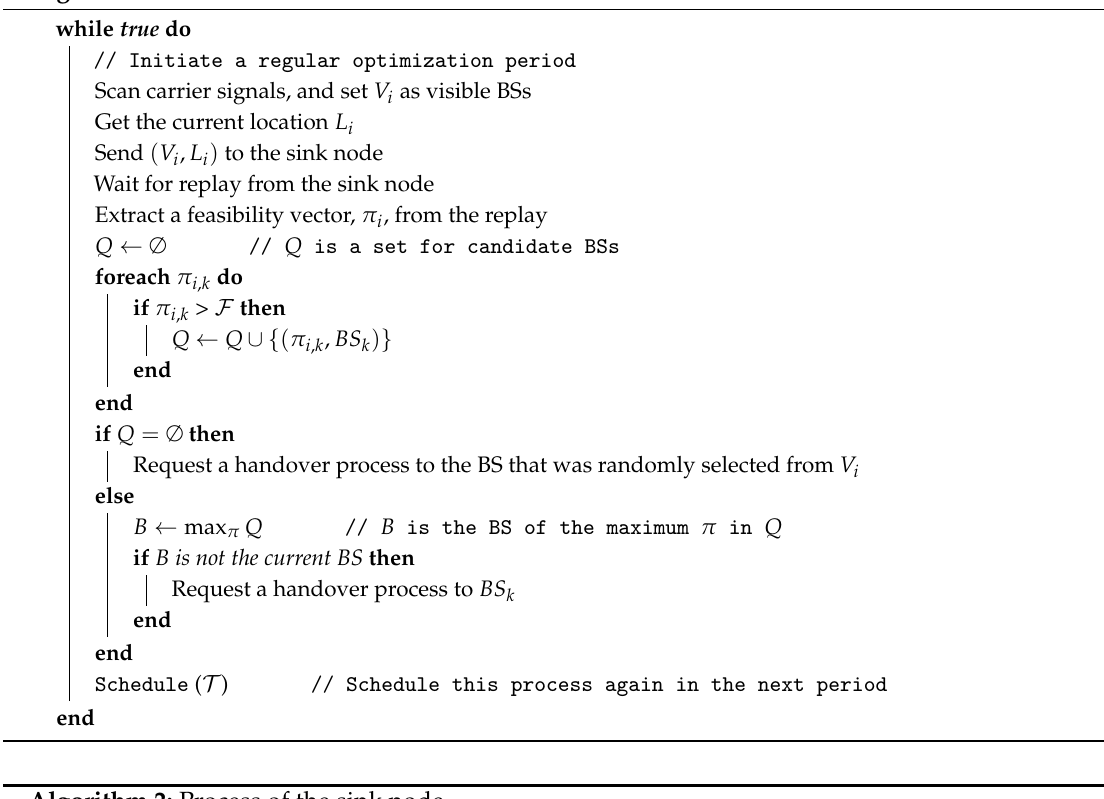
Algorithm 2: Process of the sink